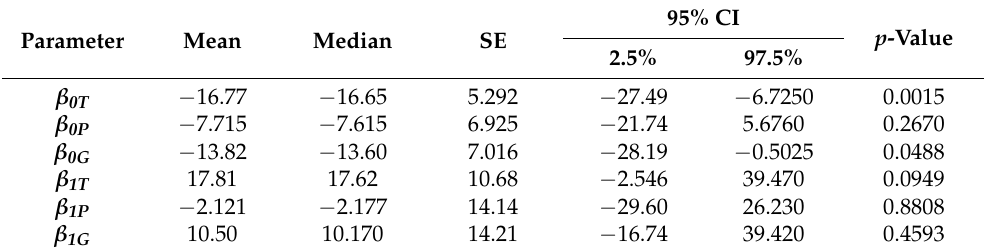
Table 2. Posterior Summaries of the Regression Coefficients (20% masked observations).